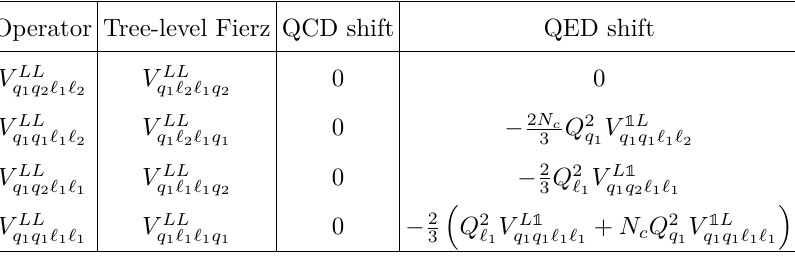
Table 2. Fierz transformations for semi-leptonic γ µ P L ⊗ γ µ P L operators together with their one- loop QCD and QED shifts in the original BMU